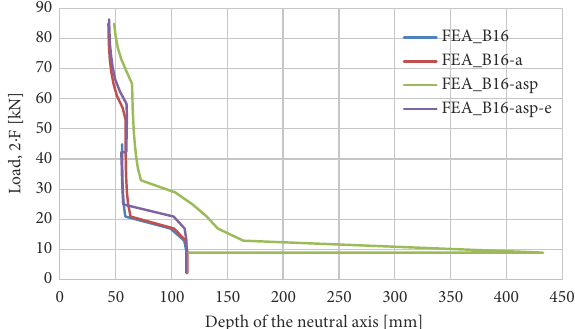
Fig. 5. Depth of the neutral axis predicted numerically. Reinforcement 4 ∅